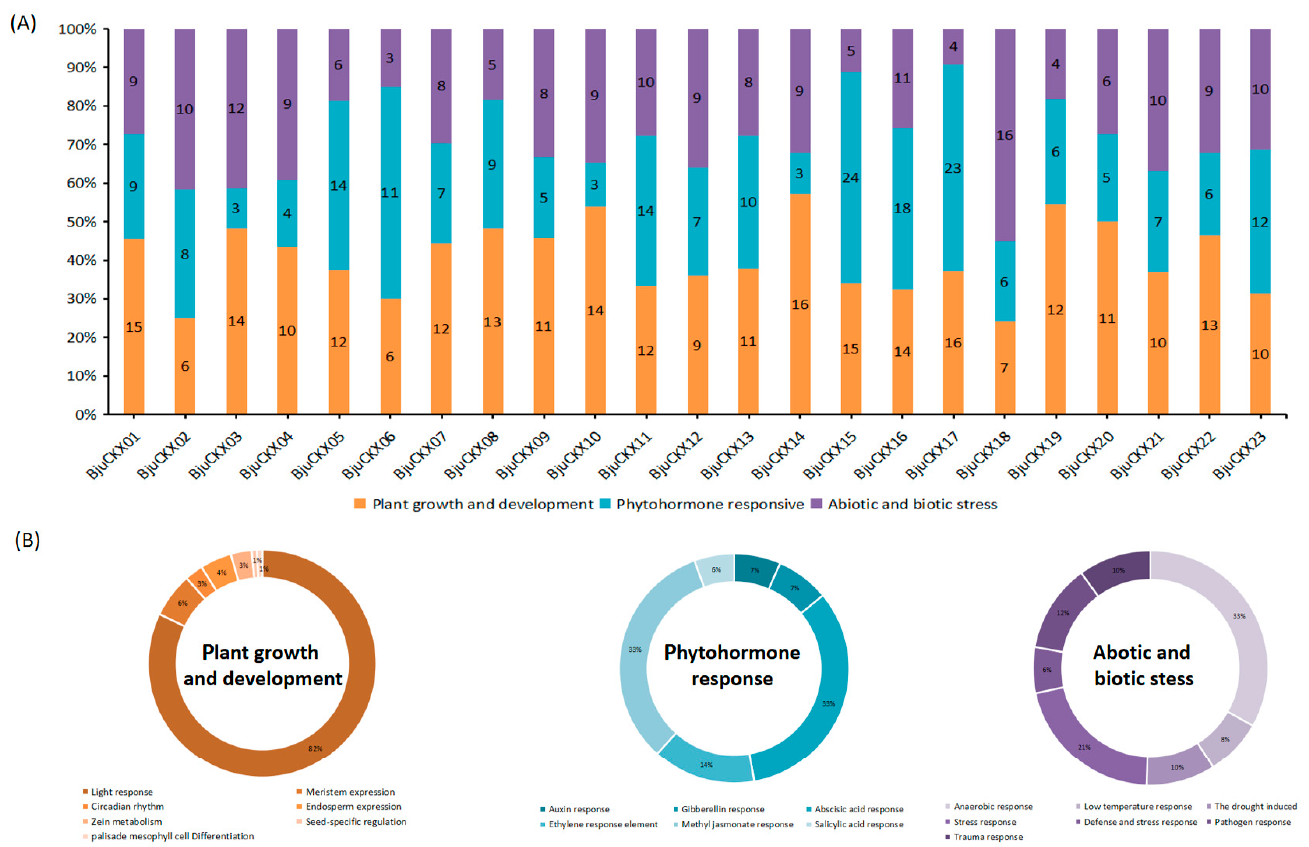
Figure 6. Cis-acting element analysis of CKX gene family in B. juncea . ( A ) The total number of elements in each gene. ( B ) The pie charts showed that the percentage of each cis-elements in each